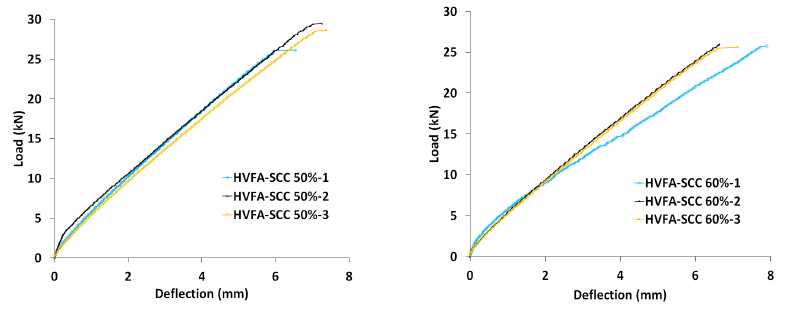
Figure 9. Load ‐ deflection curves of HVFA ‐ SCC beams.